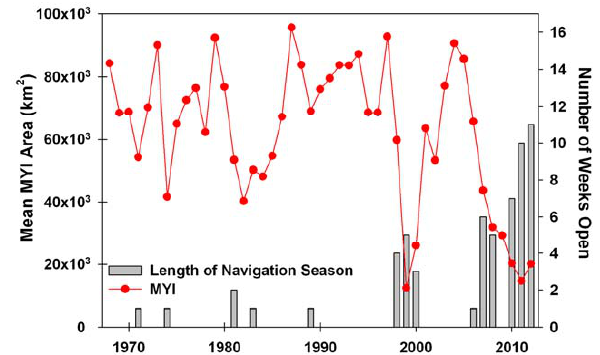
Figure 15. Time series of the length of the navigation season for the northern route of the Fig. 15. Time series of the length of the navigation season for the Northwest Passage and mean multi-year ice (MYI) area within the region, 1968-2012. The northern route of the Northwest Passage and mean multi-year ice navigation season is defined by the Canadian Ice Service as a 17-week time window from June (MYI) area within the region, 1968–2012. The navigation season 25 th to October 15 th . is defined by the Canadian Ice Service as a 17-week time window Figure 14. Time series of ICESat and IceBridge winter Arctic sea ice thickness anomalies in the from 25 June to 15 Fig. 14. Time series of ICESat and IceBridge winter Arctic sea Canadian Basin just north of the Canadian Arctic Archipelago, 2004-2012. Anomalies are ice thickness anomalies in the Canadian Basin just north of the calculated with respect to the 2004-2012 period. Canadian Arctic Archipelago, 2004–2012. Anomalies are calcu- lated with respect to the 2004–2012 period.